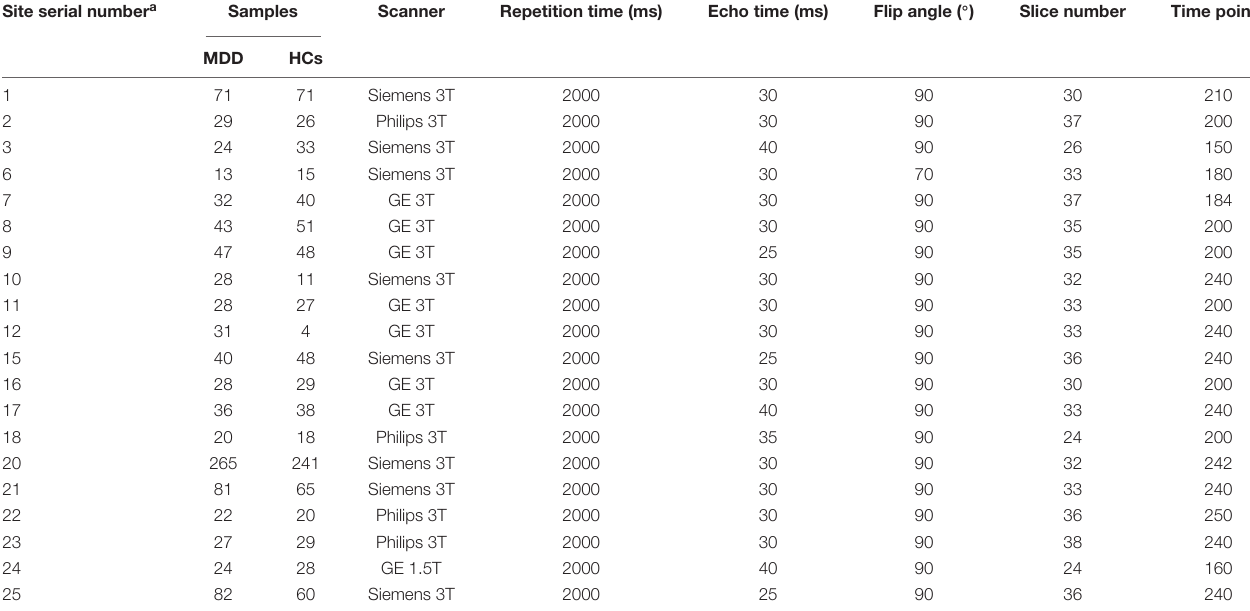
TABLE 1 | The sample size and key data acquisition parameters of each site included in this study. Site serial number a